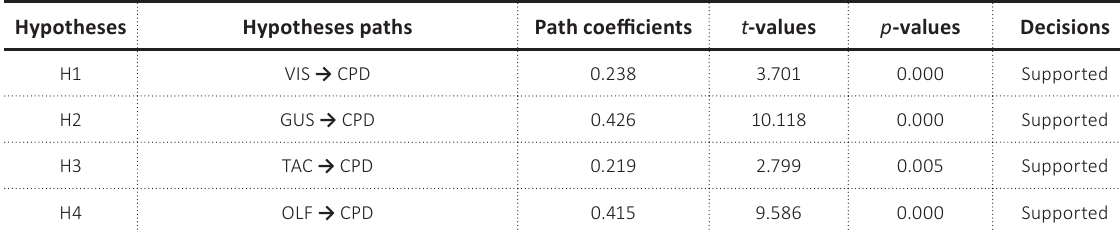
Table 3. Bootstrapping results of the structural model and path analysis